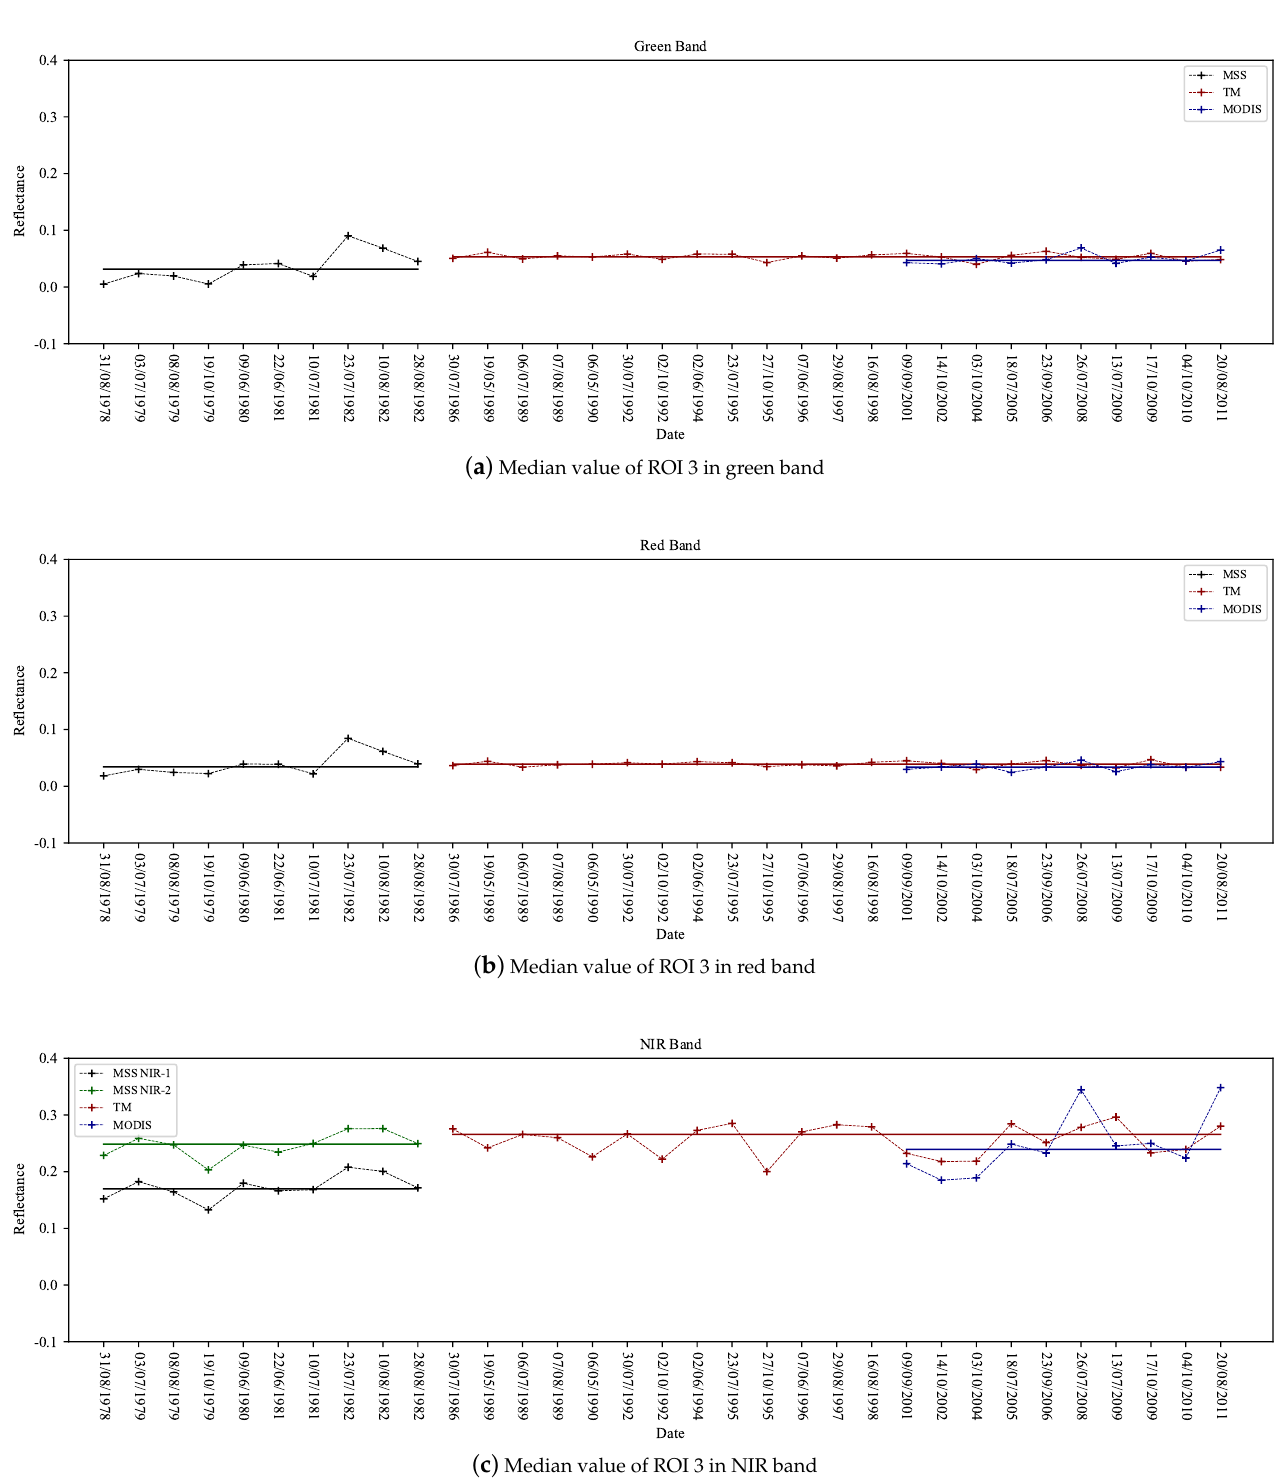
Vegetation Index (NDVI) should be calculated by the MSS red and NIR-2 bands.